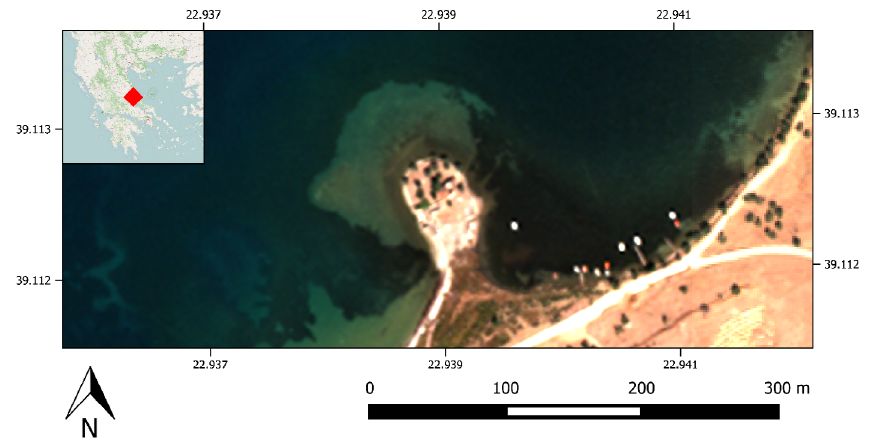
Figure 1: An overview of the Meothi archaeological site using WorldView-2 true-color composite